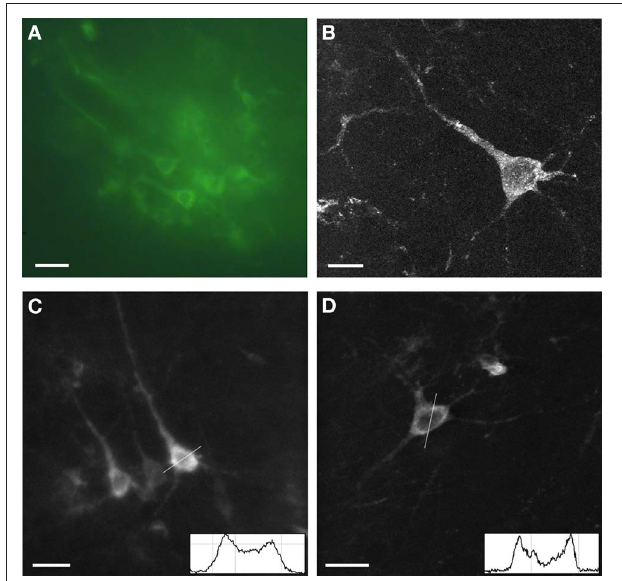
FIGURE 1 | Expression of Sindbis Flare in fixed tissue. (A) Fluorescence microscope image of field of labeled neurons. (B) High power confocal image of a single neuron transfected with Flare (10 μ m stack, 0.5 micron sections). (C,D) Confocal images of labeled neurons. No more than third-order dendrites are labeled. Insets show gray scale profiles (membrane brightness relative to cell plasma: 44%, A ; 83%, B ; distance; 25 μ m) across selected cell bodies. Scale bars, 10 μ m (A) , 5 μ m (B) , 20 μ m (C,D)